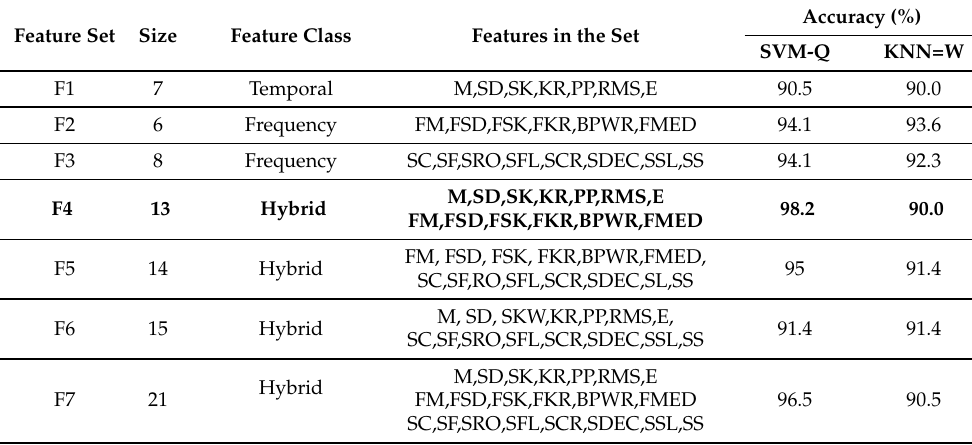
Table 3. Performance evaluation of different feature sets combination with several classifiers Feature Set